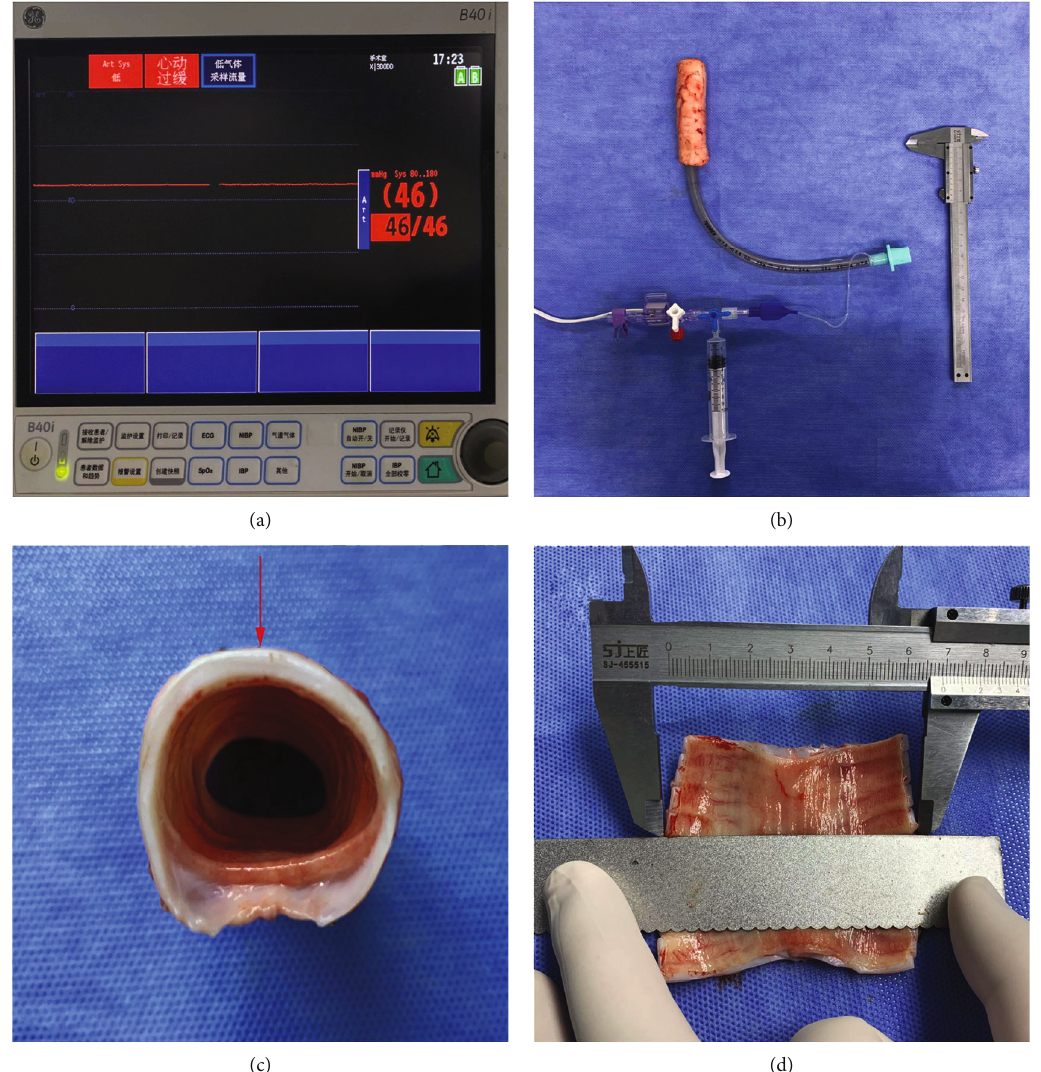
Figure 1: (a) The waveform and value of endotracheal tube cu ff pressure displayed on the monitor. (b) Pressure monitoring device for endotracheal tube cu ff pressure, including endotracheal tube cu ff guide balloon, a 10 ml syringe and pressure monitoring sensor. (c) The point where to cut trachea (red arrow). (d) Measurement of tracheal